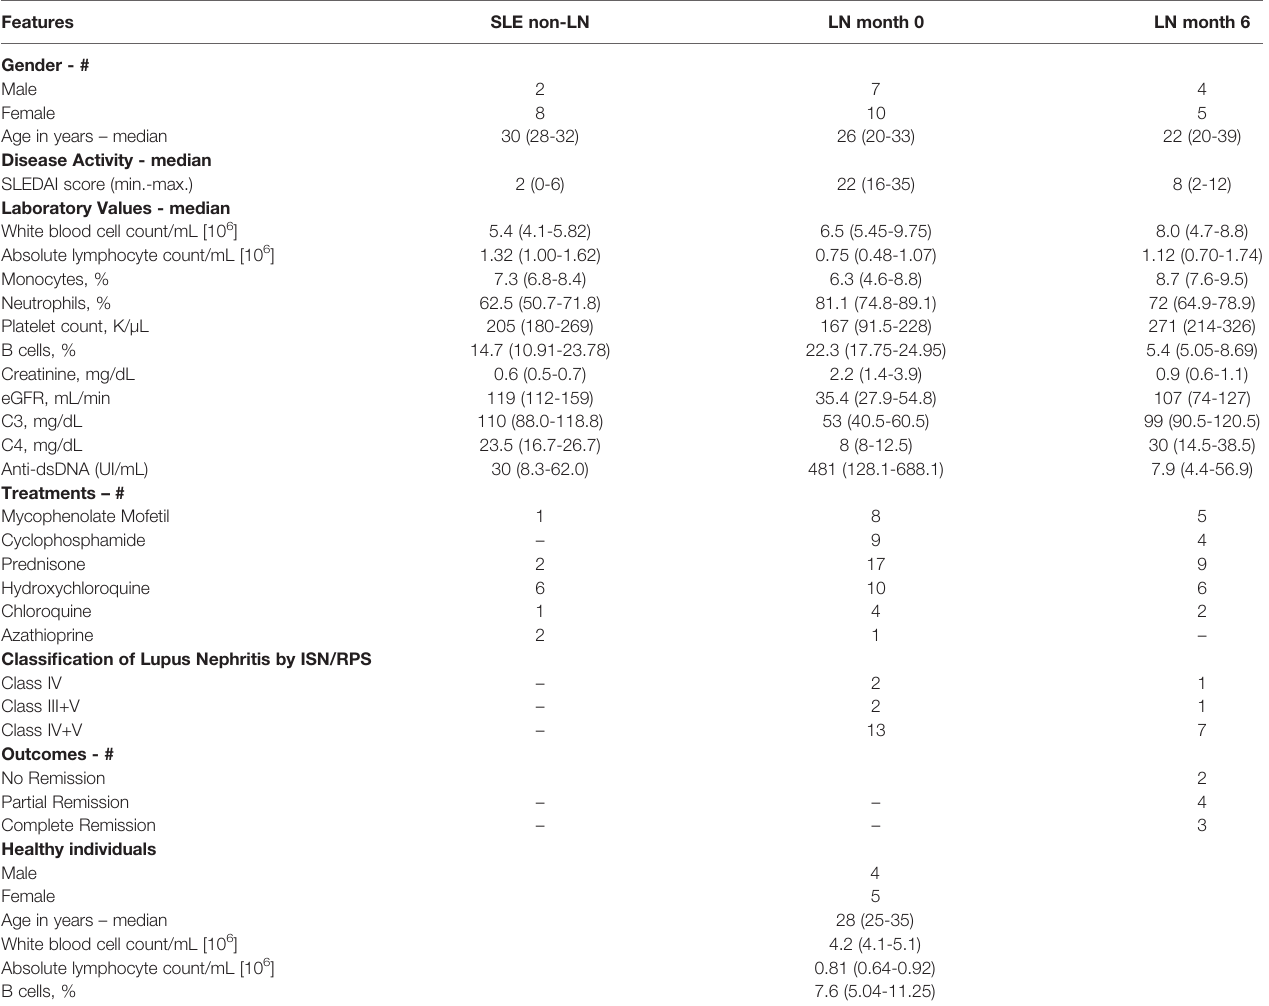
TABLE 1 | Demographics, clinical and laboratory features of SLE/LN patients. Features